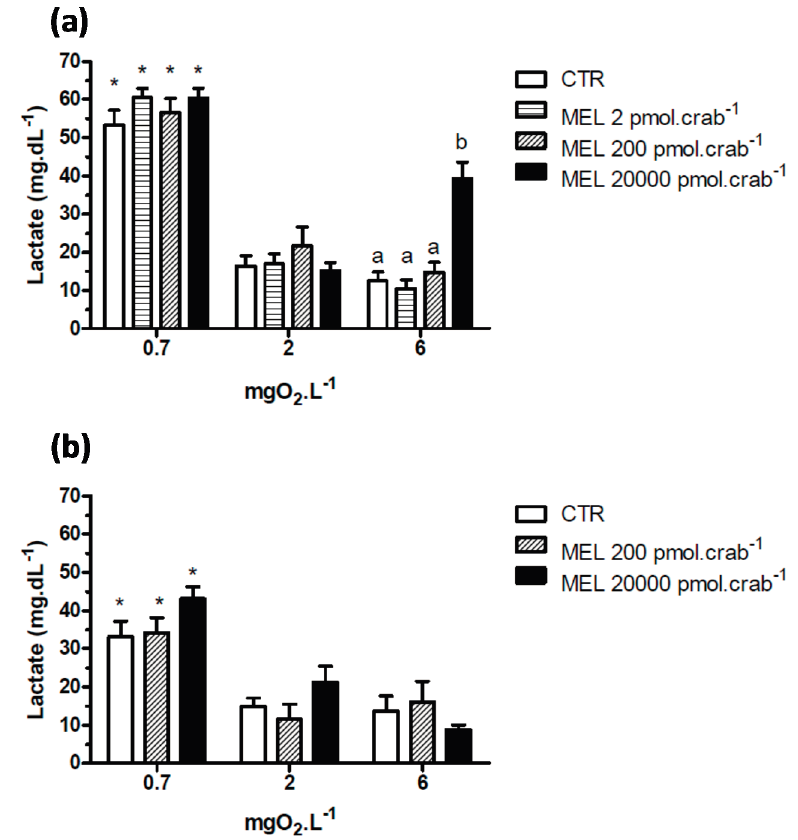
Figure 5. Circulating lactate in ( a ) intact and ( b ) eyestalkless Neohelice granulata exposed for 45 min to three different dissolved oxygen concentrations (0.7, 2 or 6 mgO 2 ·L − 1 ) and injected with physiological saline (CTR) or melatonin (2, 200 or 20,000 pmol·crab − 1 ). Each point represents the mean ± SE ( n = 4–7). Different letters represent significant differences ( p < 0.05) between the groups with the same dissolved oxygen concentration.